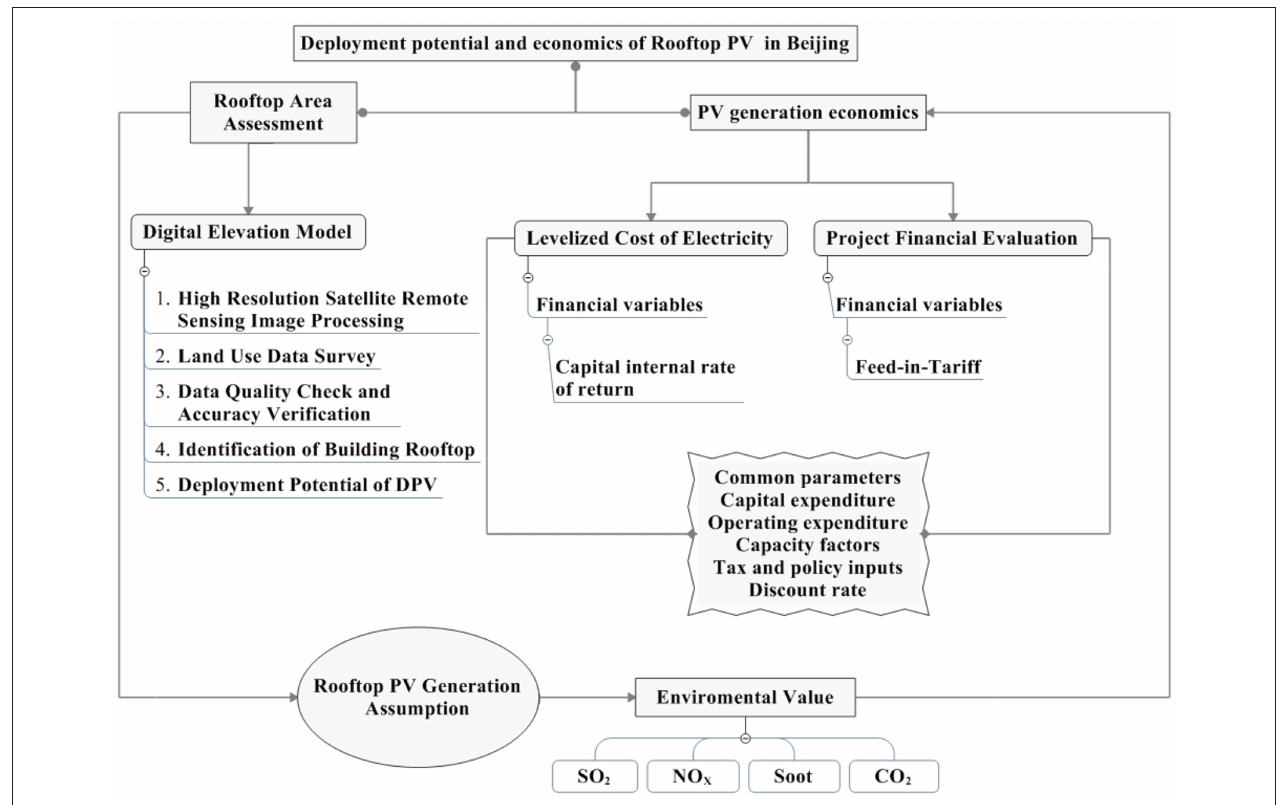
FIGURE 2 | Overall research